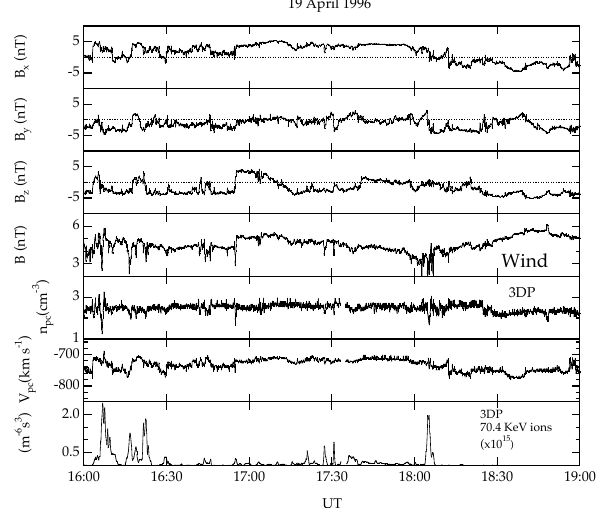
Figure 5. IMP-8, Interball-1, and Geotail energetic ion pitch angle Fig. 5. IMP-8, Interball-1, and Geotail energetic ion pitch angle dis- distributions. The top panel shows pitch angle distributions for the tributions. The top panel shows pitch angle distributions for the L1 L1 (50-220 keV) channel on IMP-8. The second panel compares (50–220keV) channel on IMP-8. The second panel compares traces for the antisunward (Detector 1, crosses) and spinning (Detector 2, traces for the antisunward (Detector 1, crosses) and spinning solid curve) sensors of the DOK-2 instrument on Interball-1. Detec- (Detector 2, solid curve) sensors of the DOK-2 instrument on tor 1 observed ions with energies from 46.3 to 60keV, whereas De- Interball-1. Detector 1 observed ions with energies from 46.3 to 60 tector 2 observed ions with energies from 48.2 to 59keV. The third panel shows Geotail pitch angle distributions for 52.7 to 61.5keV keV, whereas Detector 2 observed ions with energies from 48.2 to ions. It was obtained by combining observations from both heads. 59 keV. The third panel shows Geotail pitch angle distributions for The bottom panel shows Geotail front to back ratios for the 52.7 to 61.5keV ions, defined as the ratio of the ion flux with pitch angles 52.7 to 61.5 keV ions. It was obtained by combining observations ranging from 0 to 90 ◦ divided by the flux with pitch angles ranging from both heads. The bottom panel shows Geotail front to back from 90 to 180 ◦ ratios for the 52.7 to 61.5 keV ions, defined as the ratio of the ion flux with pitch angles ranging from 0 to 90° divided by the flux with pitch angles ranging from 90 to 180°.